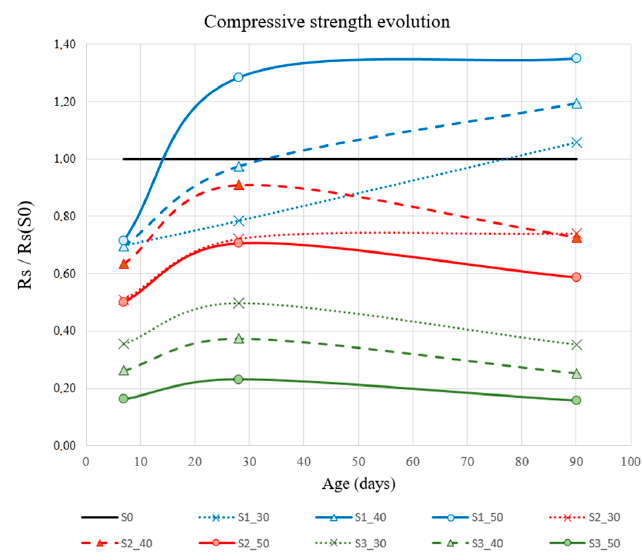
Figure 7. Compressive strength evolution (Rs/Rs( S0